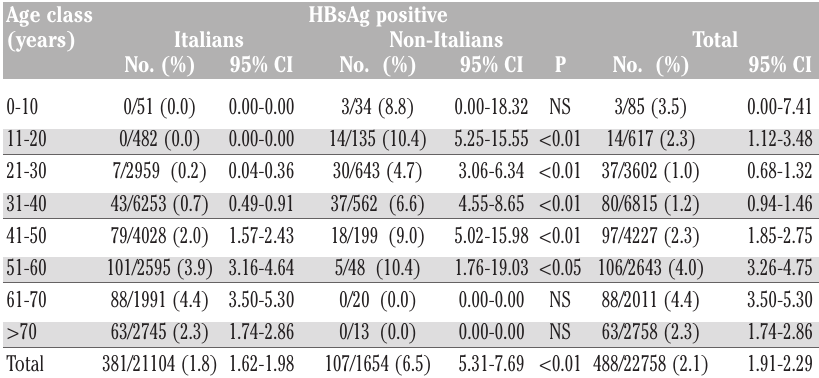
Table 3. Hepatitis B surface antigen (HBsAg) seropositivity in Italian and non-Italian patients by age class